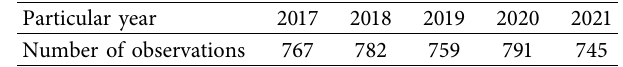
Table 3: Sample observations of empirical